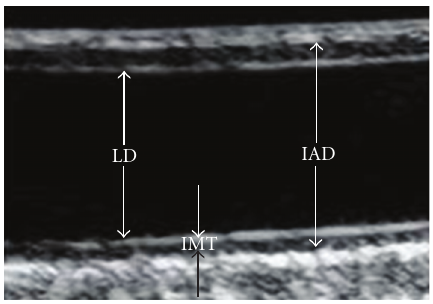
Figure 1: Measurement of the common carotid artery lumen diameter (LD), intima media thickness (IMT), and interadventitial diameter (IAD) also known as adventitial